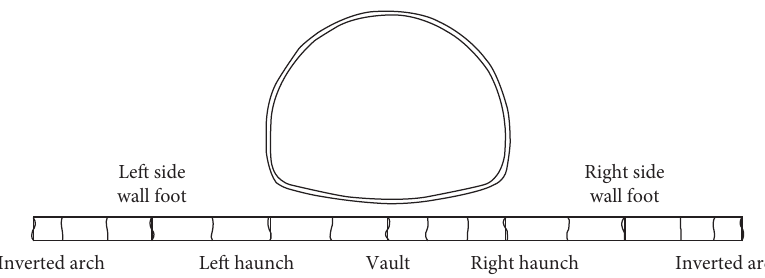
Figure 11: Distribution map of lining cracks of basalt fiber-reinforced